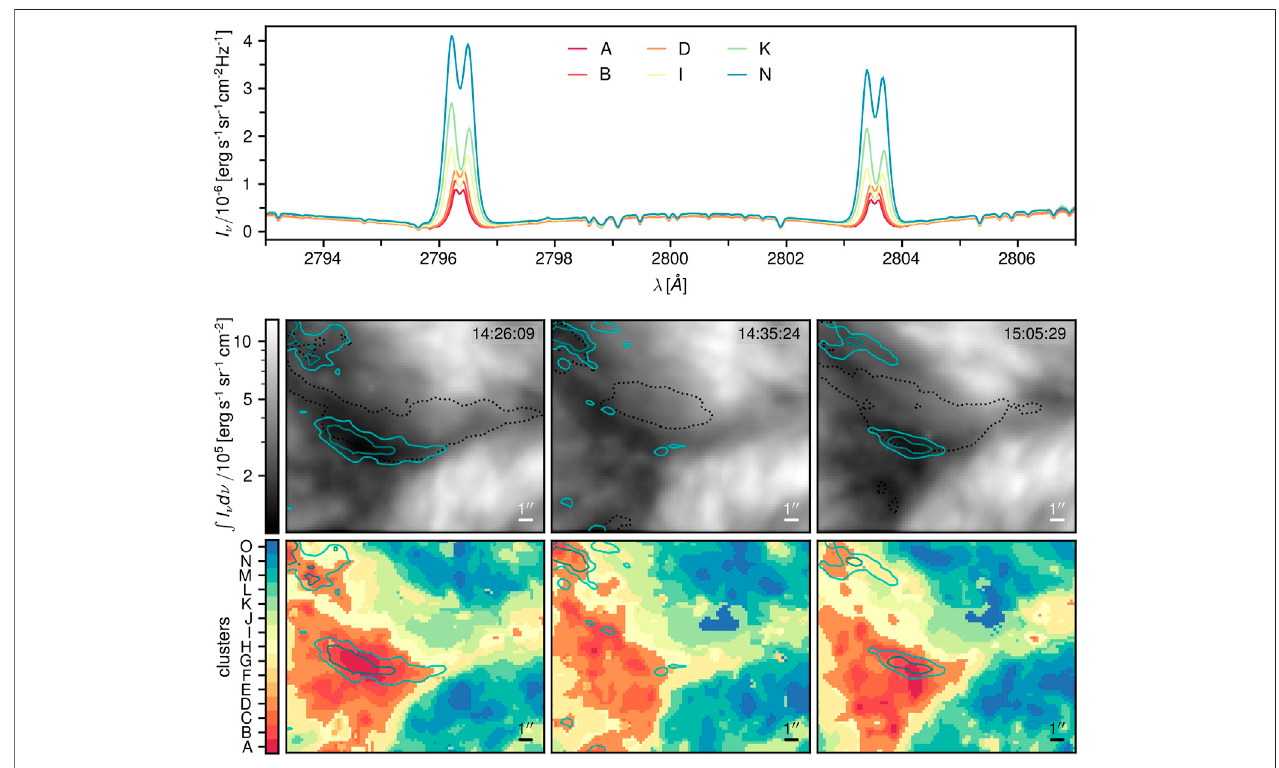
FIGURE 3 | Clustering of Mg II h and k pro fi les in an AR fi lament. Upper panel: mean spectral pro fi les ofselected clusters. Middle panel: integrated intensity in the k line in logarithmic scale within the region delimited by the horizontal lines in Figure 2 . Lower panel: clusters of Mg II h and k pro fi les. The light and dark blue contours correspond to T b (1.25 mm) = 5,000 and 4,500 K, and the dotted black contours outline the fi lament boundary in the AIA304 Å